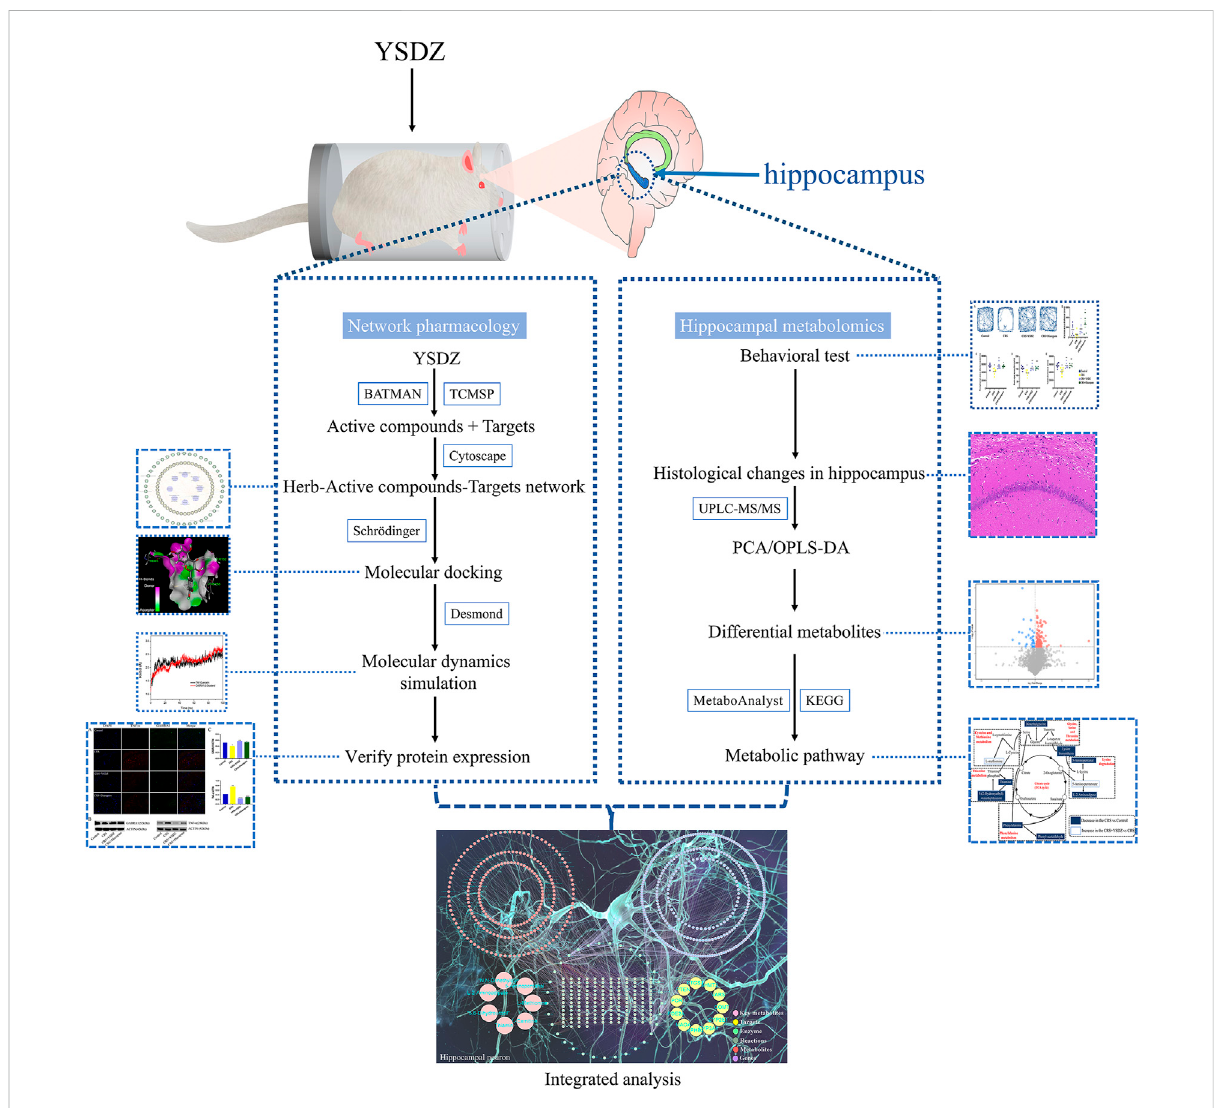
FIGURE 2 Framework of the